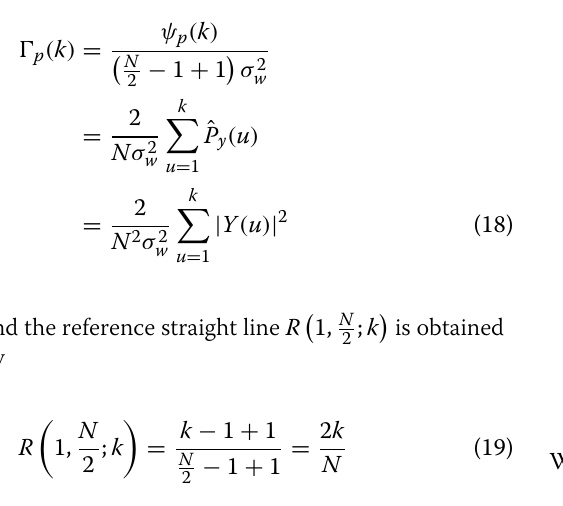
T p detector aims at finding the difference between (cid:8) ( k ) and the corresponding reference p